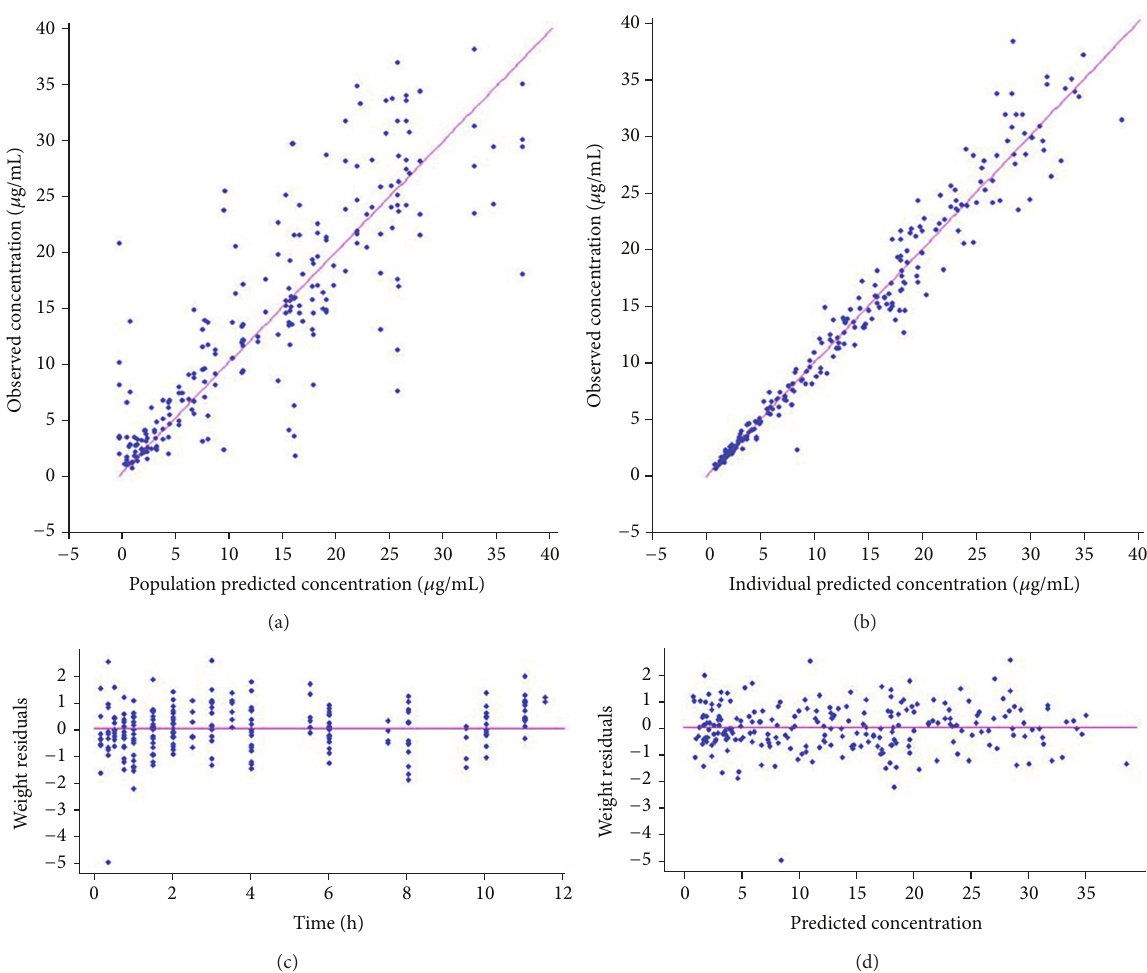
Figure2:Goodnessoffitplots.(a)Observedversuspopulationpredictedand(b)observedversusindividualpredictedvalues.Thecontinuous line is the identity line, (c) scatter plot of weighted residuals versus time and (d) scatter plot of weighted residuals versus predicted cephalexin